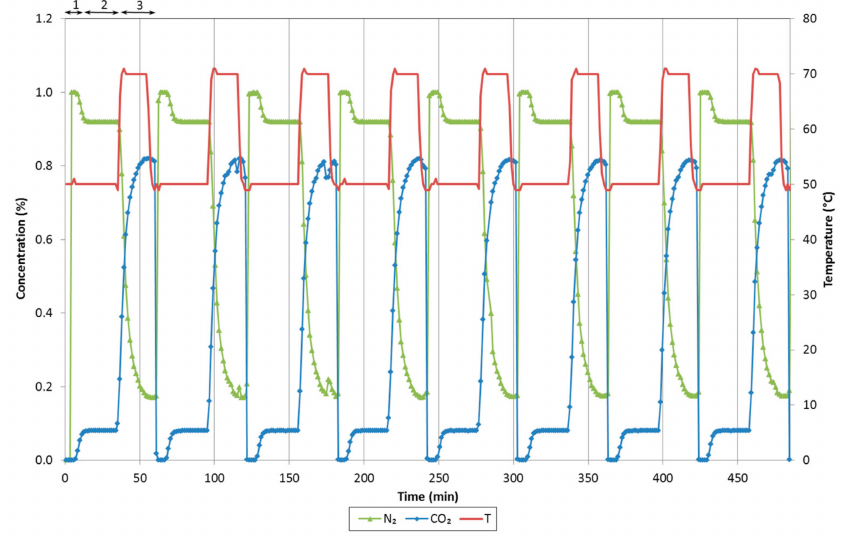
Figure 5. Example of eight adsorption–desorption cycles at 50 ◦ C for a mixture of 8/92 vol % CO 2 /N 2